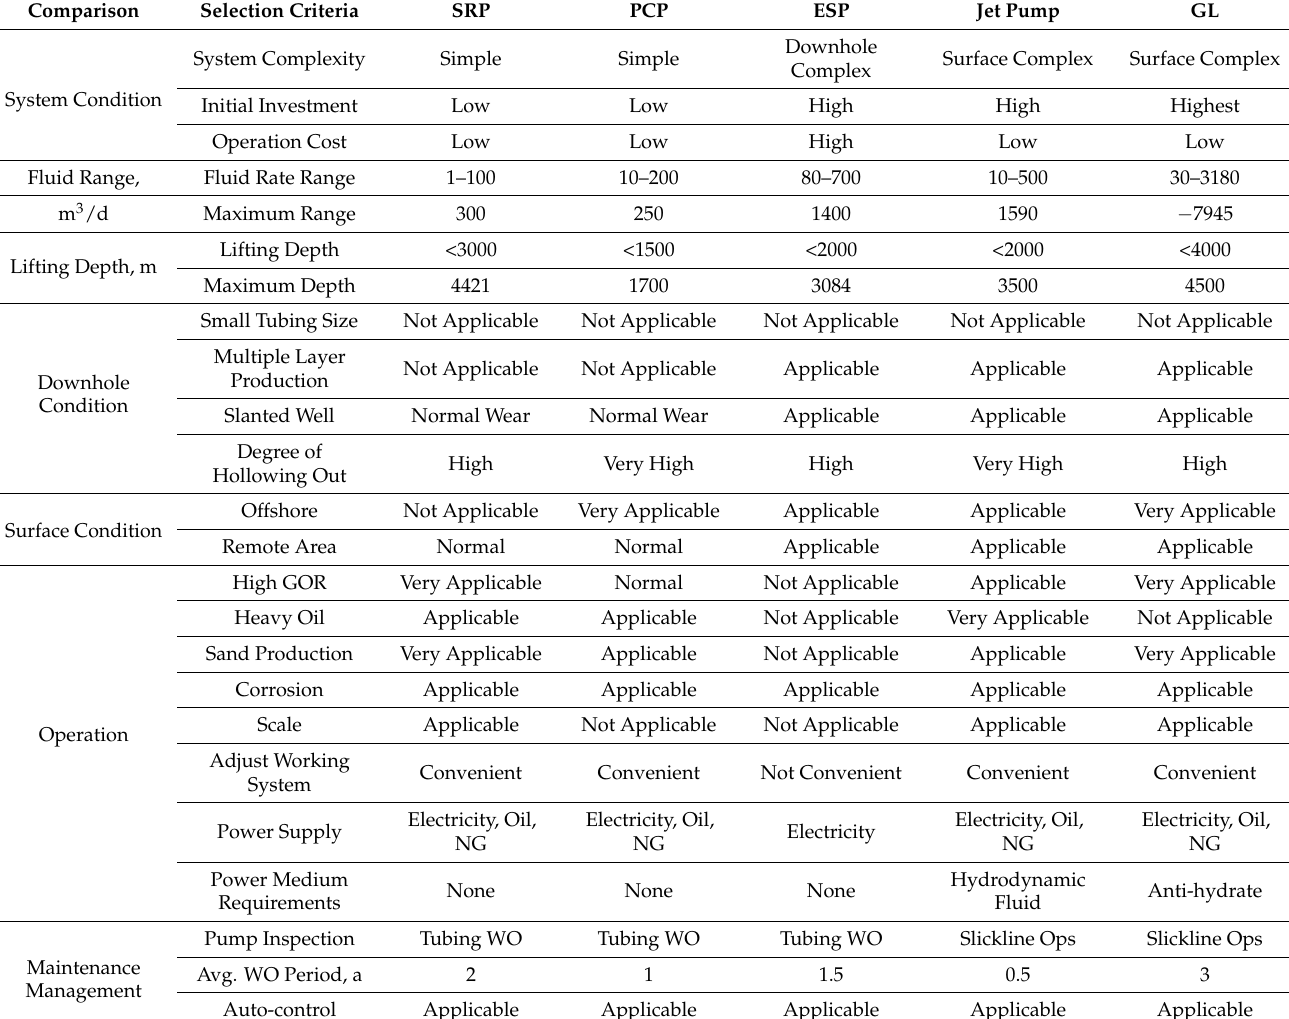
Table 1. Candidate selection criteria for different gas well de-liquification